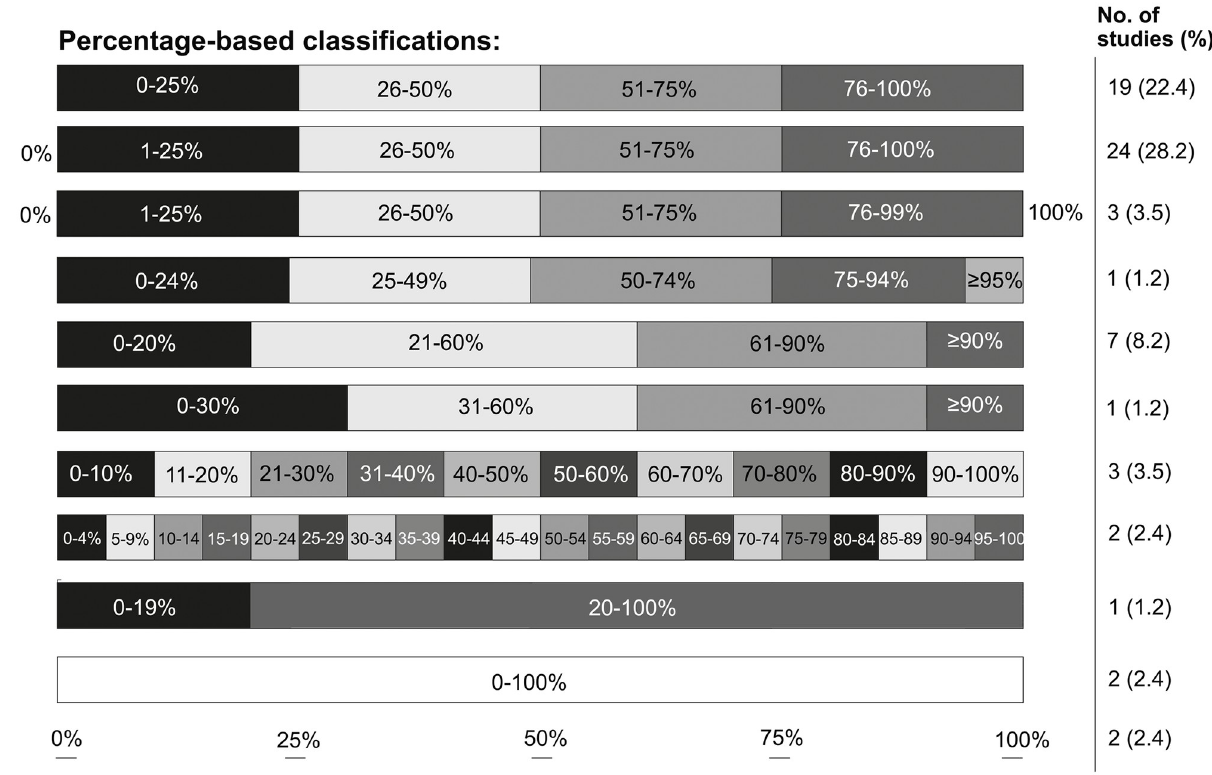
Fig 4. Scoring systems used to classify observer/clinician-reported percentage ‘improvement’, ‘lightening’, ‘clearance’ or ‘blanching’ for global assessment of port wine stain improvement. The percentage-based scoring systems in Table 1 were stratified according to their categories.